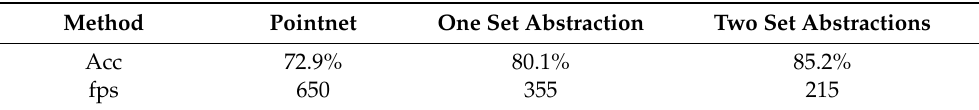
Table 2. Performance evaluation with different structures of a Siamese network on the Pan- dora dataset.